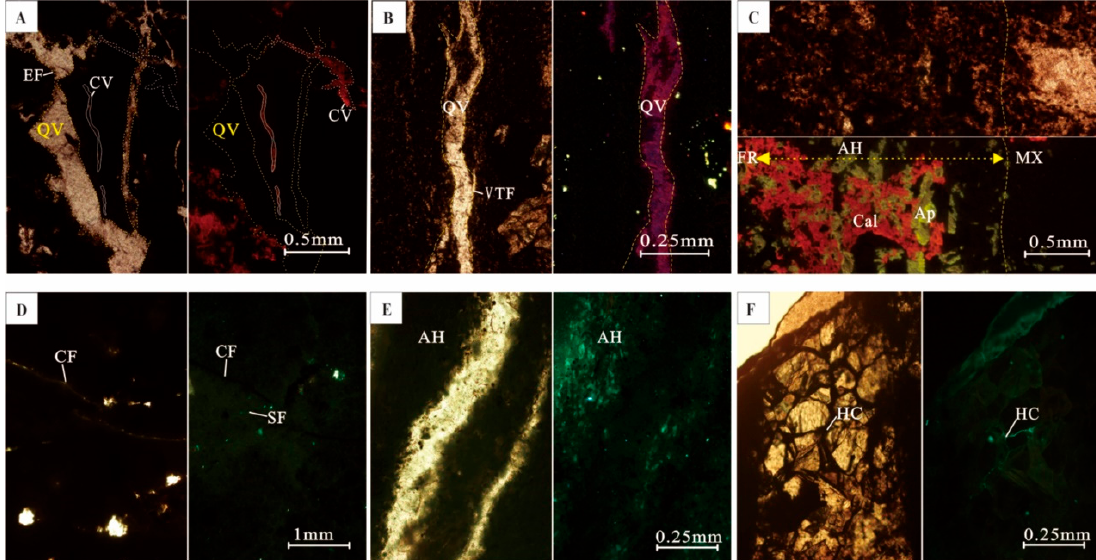
Figure 5. Photomicrographs of fracture fillings and alteration haloes under cathodoluminescence microscopy and ultraviolet light from the Carboniferous Batamayineishan Formation, Dixi Area. ( A ) Calcite vein (CV) filled in fractures emitting orange light under cathodoluminescence (CL) microscopy, quartz vein (QV) in explosion fractures not emitting, DX1824 well, 3637.48 m, plane-polarized light/CL; ( B ) quartz vein filled in the vertical tension fractures emitting purple-red light under cathodoluminescence microscopy, DX1824 well, 3548.3 m, plane-polarized light/CL; ( C ) calcite emitting orange light, metasomatic matrix (MX) minerals, apatite (Ap) emitting yellow light can be seen in the calcite, D18 well, 4058.55 m, plane-polarized light/CL; ( D ) contraction fractures are dislocated by structural fracture, structural fracture (SF) emitting blue fluorescence, but not in contraction fracture, DX1824 well, 3637.48 m, plane-polarized light/ultraviolet light; ( E ) micro pores abundant in alteration haloes on both sides of cracks, emit blue fluorescence, DX1824 well, 3548.3 m, plane-polarized light/ultraviolet light; ( F ) hydrocarbons occur along calcite grains boundary, emit blue-white light, presenting a relatively high maturity, D18 well, 4058.55 m, plane-polarized light/ultraviolet light. CF = contraction fracture; EF = explosion fracture; SF = structural fracture; VTF = vertical tension fracture; WF = weathered fracture. AH = alteration halo; Ap = apatite; Cal = calcite; HC = hydrocarbon; MX = matrix.